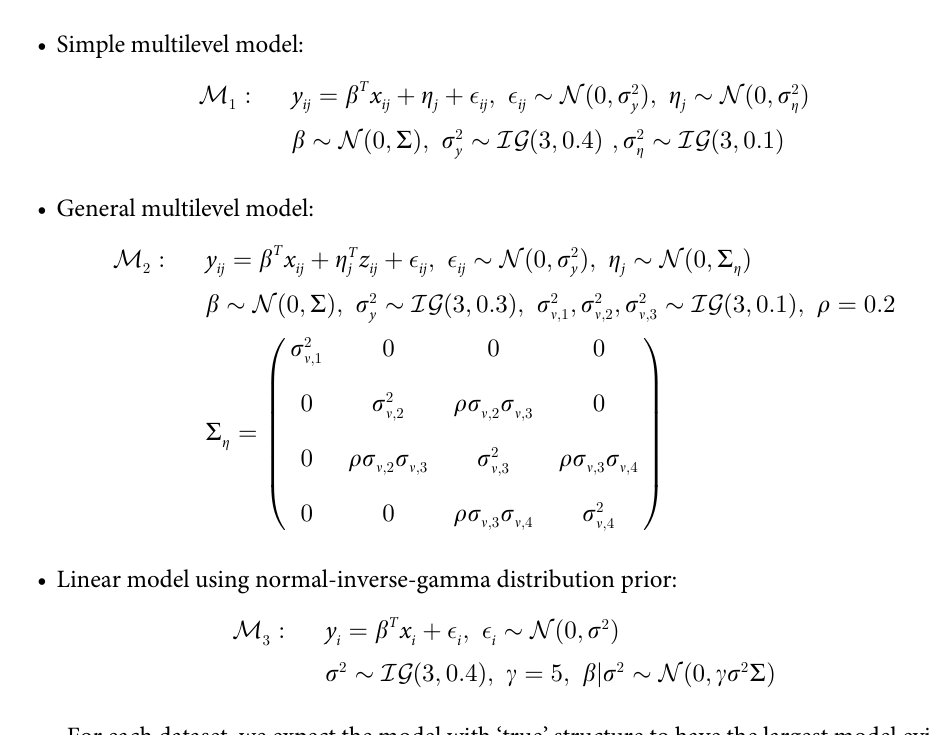
Table 1. Comparison of model evidence for each simulated dataset and model. This was computed with sequential Monte Carlo (SMC), using the integrated likelihood and separately using the full likelihood. This was repeated for 8 random initialisations with 2000 draws at each step in SMC, and we present the mean and standard devia- tion of the model evidence from each run. For each approach, the model with the strongest evidence is marked with � (this is not clear for D the repository [17] for full results). For each model, we also report the time taken to complete the sampling for all initialisations, averaged across the different